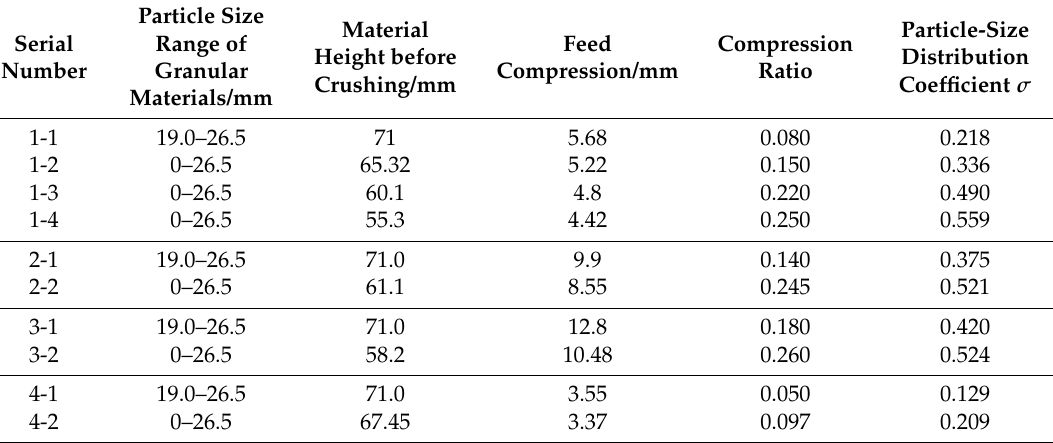
Table 1. Test results of laminated